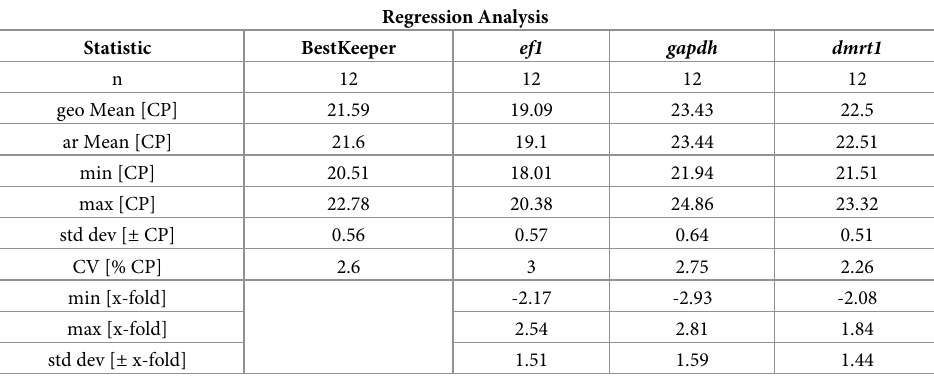
Table 3. Housekeeping gene evaluation with